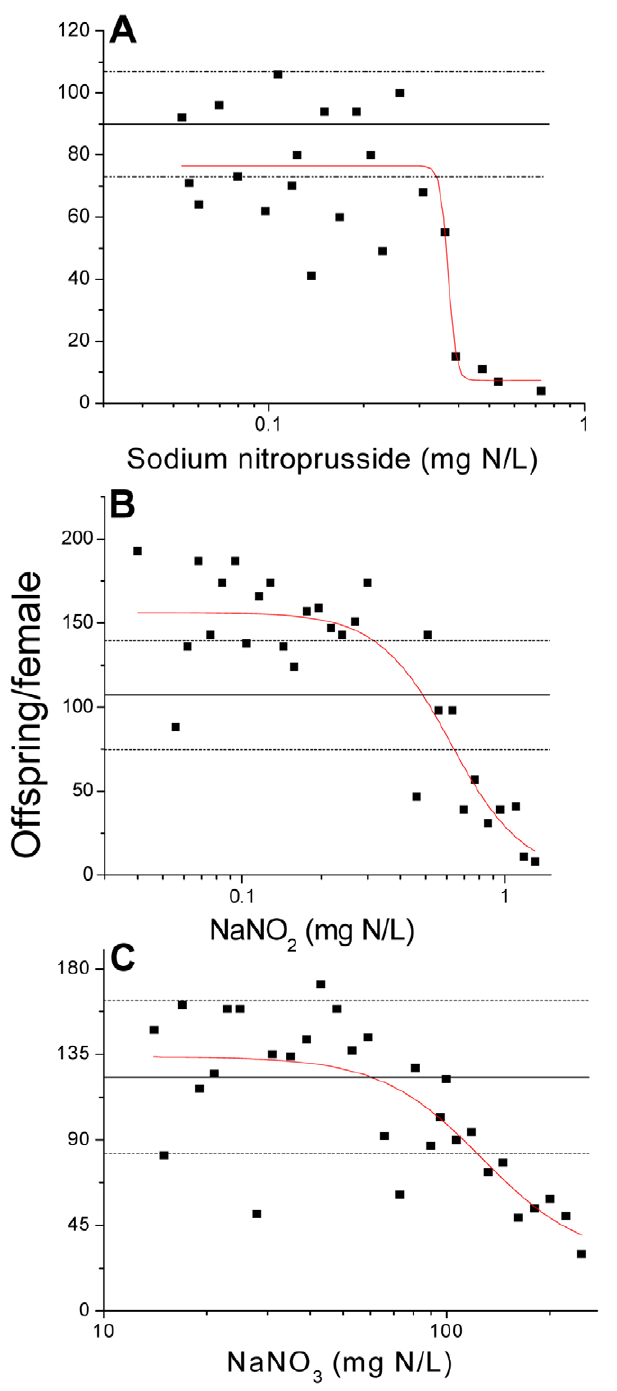
Figure 4. Total offspring released from daphnids chronically exposed to increasing concentration of (A) sodium nitroprus- side, (B) NaNO 2 , or (C) NaNO 3 . Each data point represents the total number of offspring released from a single exposed daphnid over the entire exposure period. Mean 6 SD negative control performance is depicted by the solid line bracketed by dotted lines. doi:10.1371/journal.pone.0012453.g004 concentration of approximately140 mg N/L (Fig. 5C). Consisten- cy in the effects observed between sodium nitroprusside and NO x